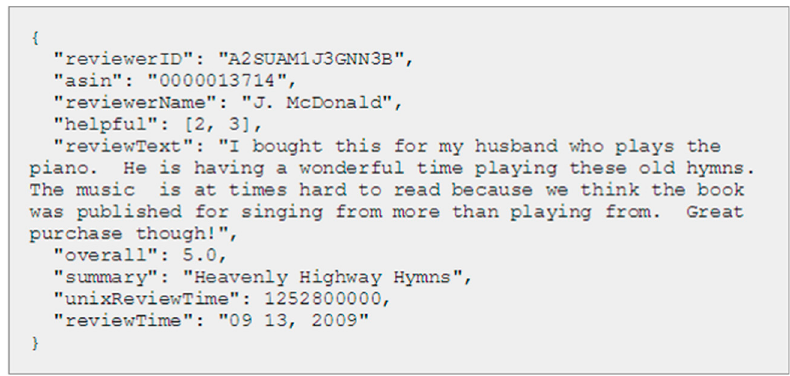
Figure 2. Original user review.